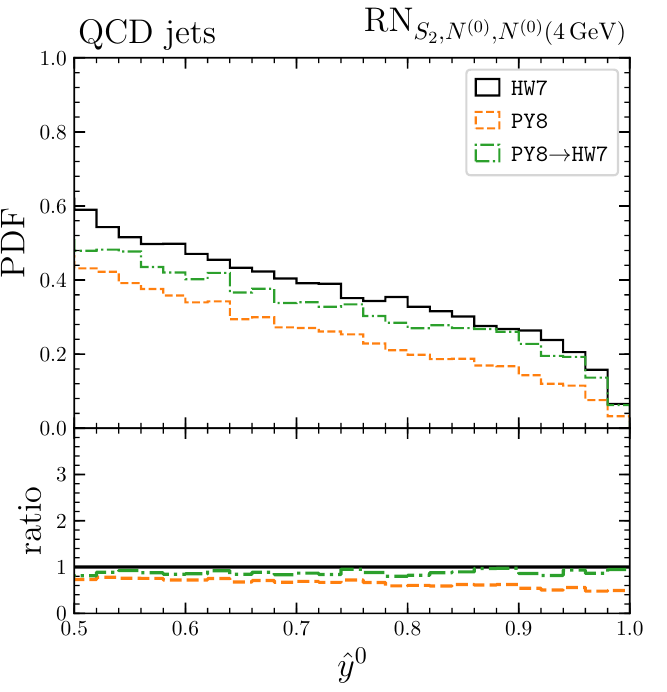
Figure 22. The score distribution of PY8 and HW7 test sample for the model trained by the HW7